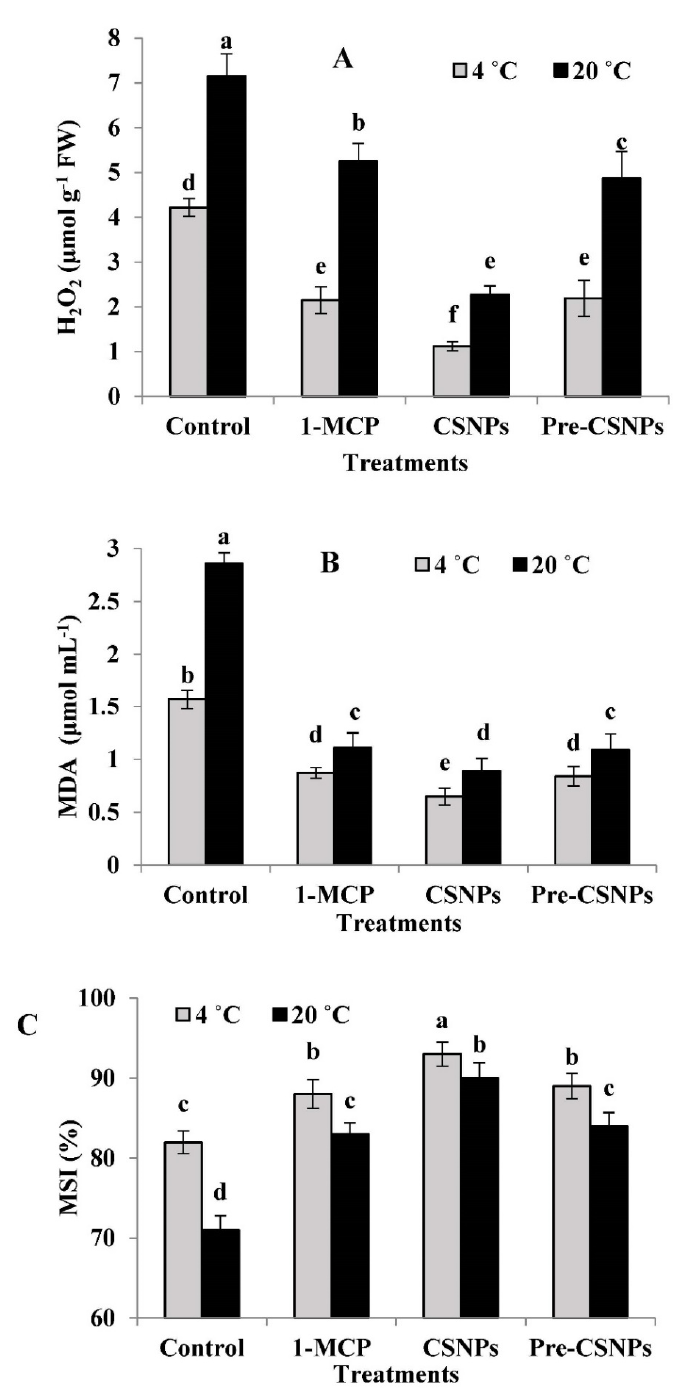
Figure 4. H 2 O 2 production ( A ), malondialdehyde ( B ) and the membrane stability index ( C ) of damask rose flowers stored at 4 or 20 °C and treated with 1-MCP and pre- and post-chitosan nanoparticles (CSNPs). Values are the means ± SE of two investigations ( n = 8). Columns with different letters are statistically different at p ≤ 0.05.